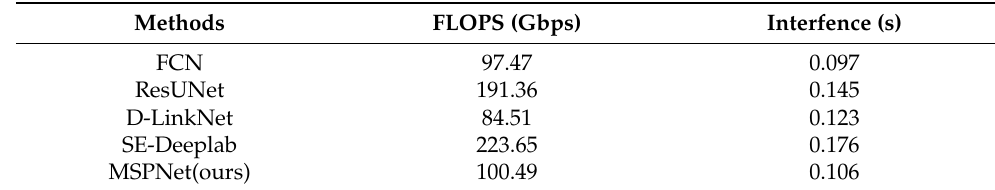
Table 4. FLOPS and inference time of our proposed MSPNet and other methods. The inference times are calculated using 10 test images and then averaged.